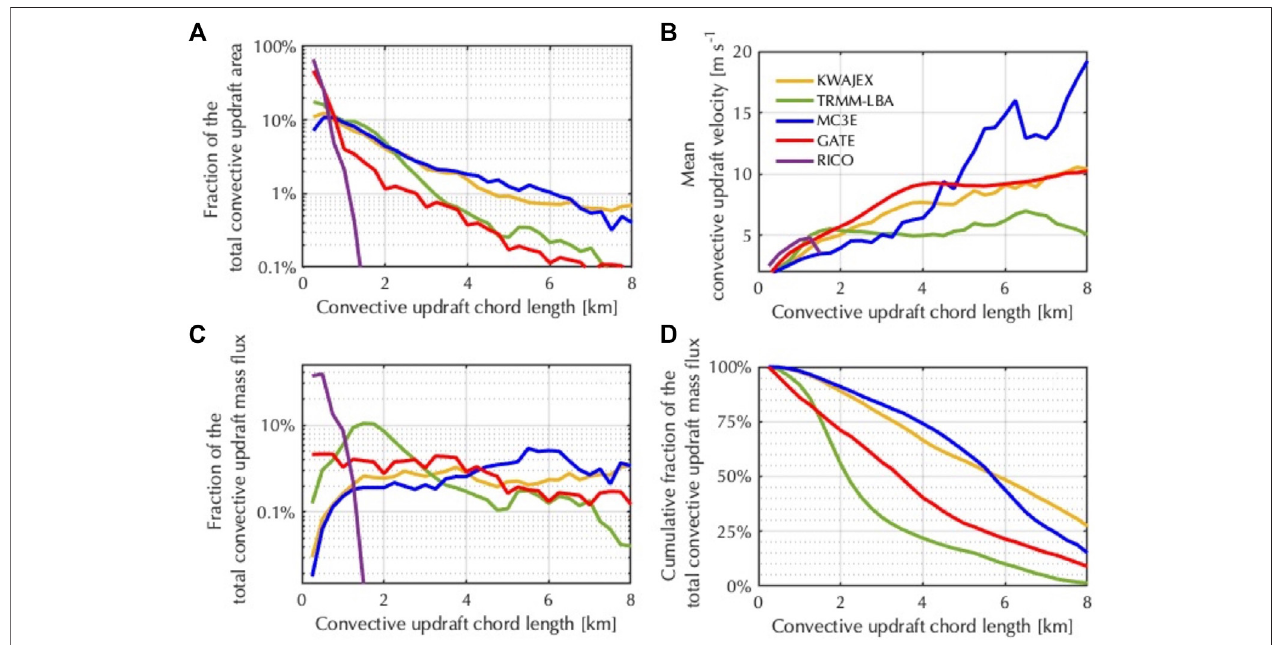
FIGURE 4 | As a function of convective updraft chord length (A) fraction area, (B) mean updraft velocity, (C) contribution to the total convective updraft mass fl ux, and (D) cumulativefractionofthetotalconvectiveupdraftmass fl uxstartingfromthelargestupdrafts. Resultsareshownforthedifferentcloudtypesunderstudy(colors as in Figure 2 ). Note that the purple line in “ d ” is not visible as it runs along the y-axis.